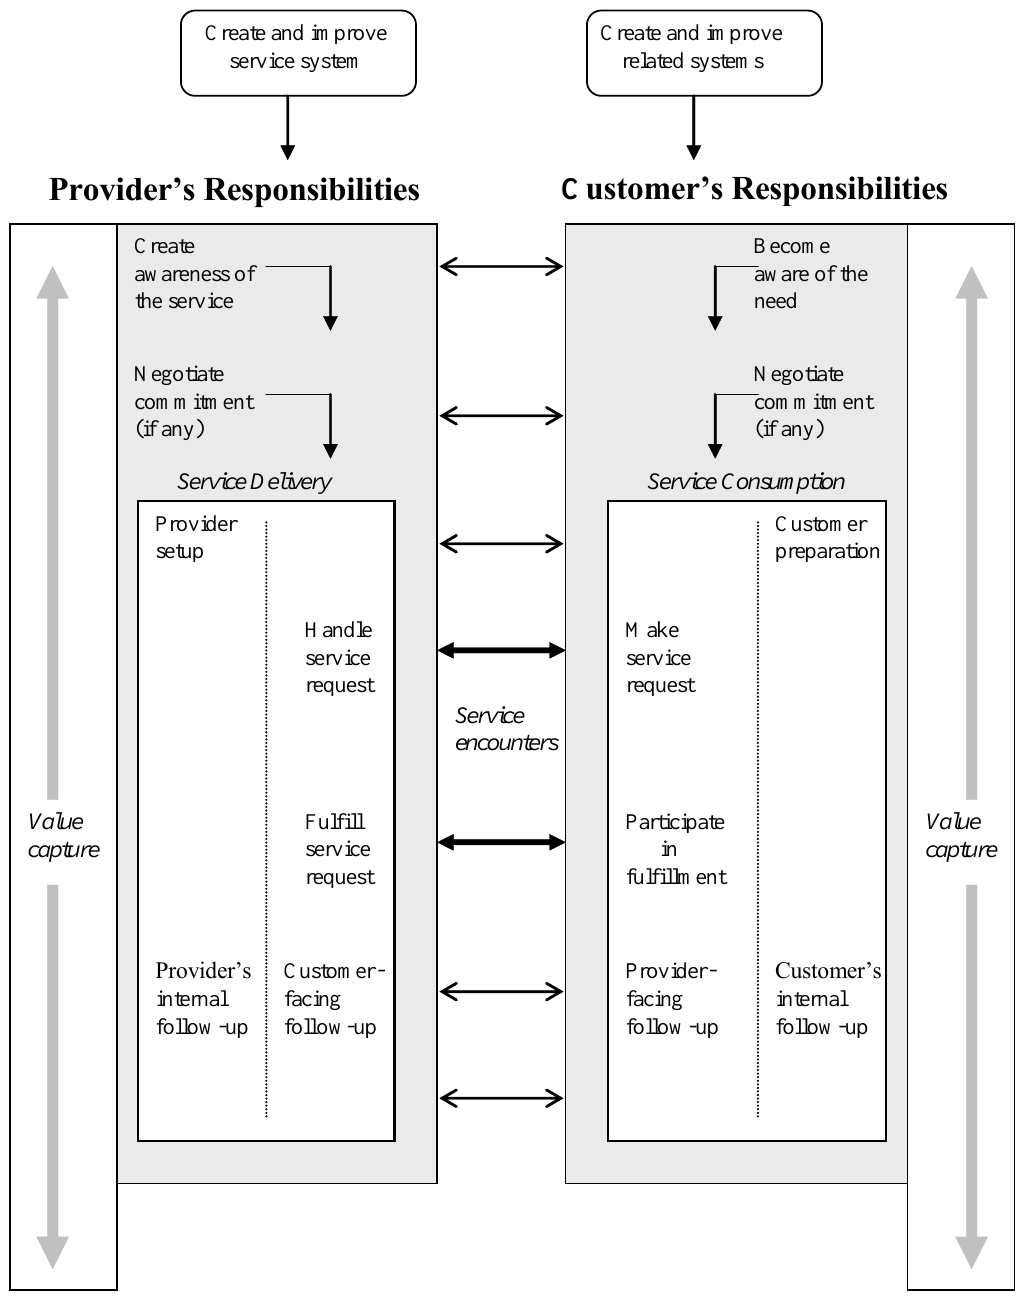
Figure 2. Service value chain framework